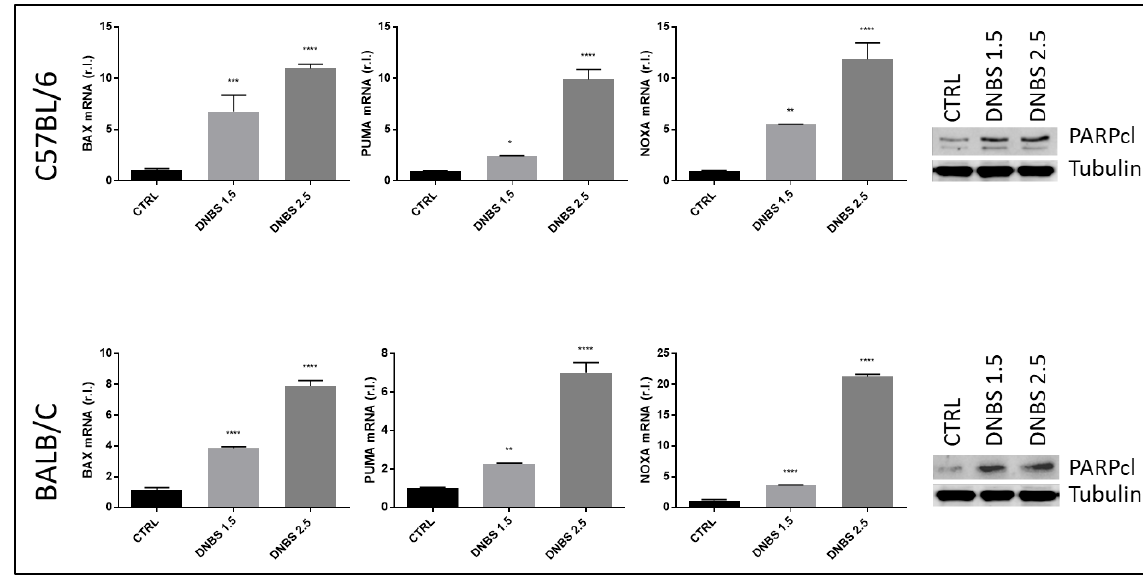
Figure 5. Apoptosis induction. Colon from C57BL/6 or BALB/c mice was cultivated for 5 h in a GEVS and untreated (CTRL) or treated with the indicated concentrations of DNBS and the expression levels of BAX and the two BH3-only proteins PUMA and NOXA, well-known pro-apoptotic markers, were evaluated by qPCR, while the cleavage of the caspases’ substrate PARP was evaluated by western blotting analysis on tissue lysates (right panels). Histograms represent mean ± SD of triplicate sample; **** p < 0.0001; *** p < 0.001; ** p < 0.01; * p < 0.1. Tubulin was used as loading control.